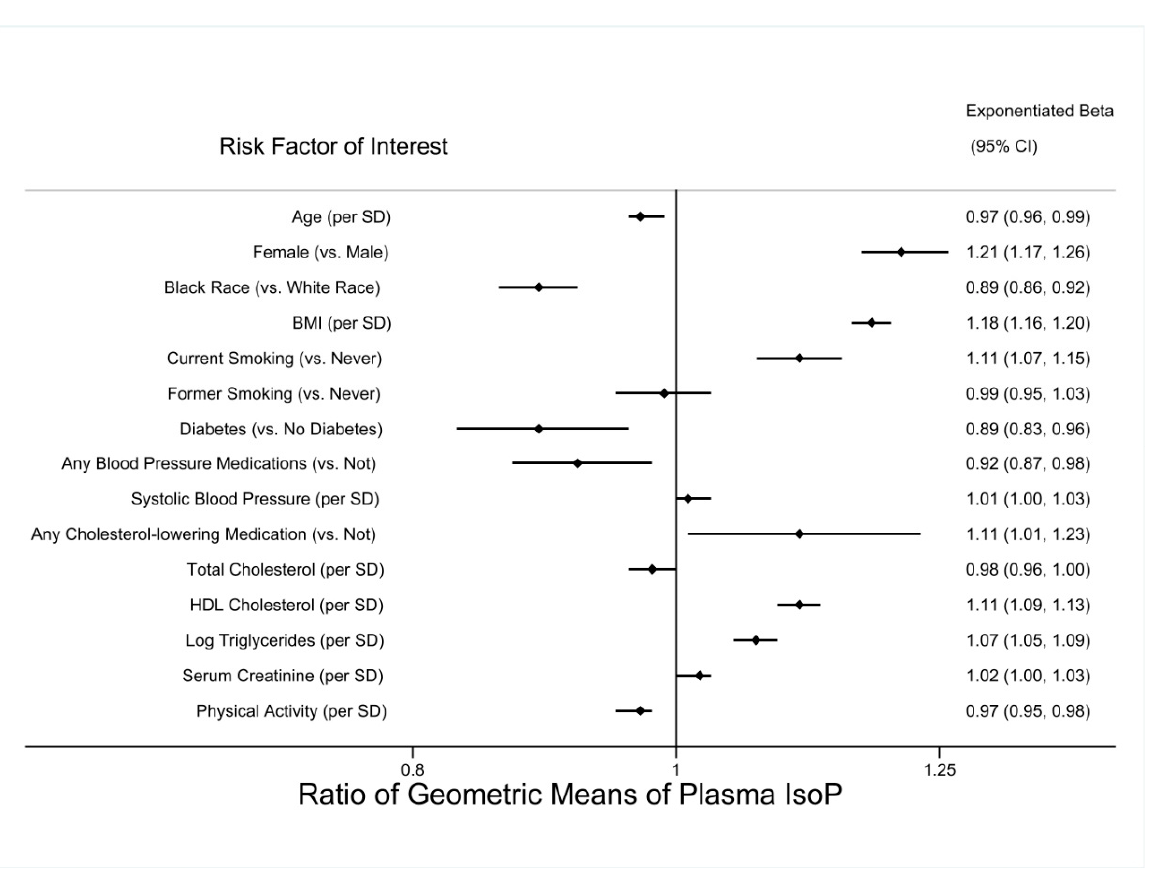
Figure 4. Adjusted associations between Plasma IsoP vs. cardiovascular risk factors. Exponentiated beta-coefficients are plotted and are equivalent to geometric ratios of analyte of interest. Ratios > 1 represent positive correlation and ratios < 1 represent inverse correlation. All CVD risk factors are mutually adjusted for one another (age, sex, race, BMI, smoking status, cumulative pack years, dia- betes, hypertension medication, systolic blood pressure, lipid-lowering medication, total cholesterol, HDL cholesterol, fasting triglyceride concentrations [log transformed], physical activity) as well as for college attainment and study center. Smoking status and cumulative pack years were highly correlated and thus were not adjusted for one another in their respective models. Table 4. Adjusted associations between Plasma IsoP vs. cardiovascular risk factors.